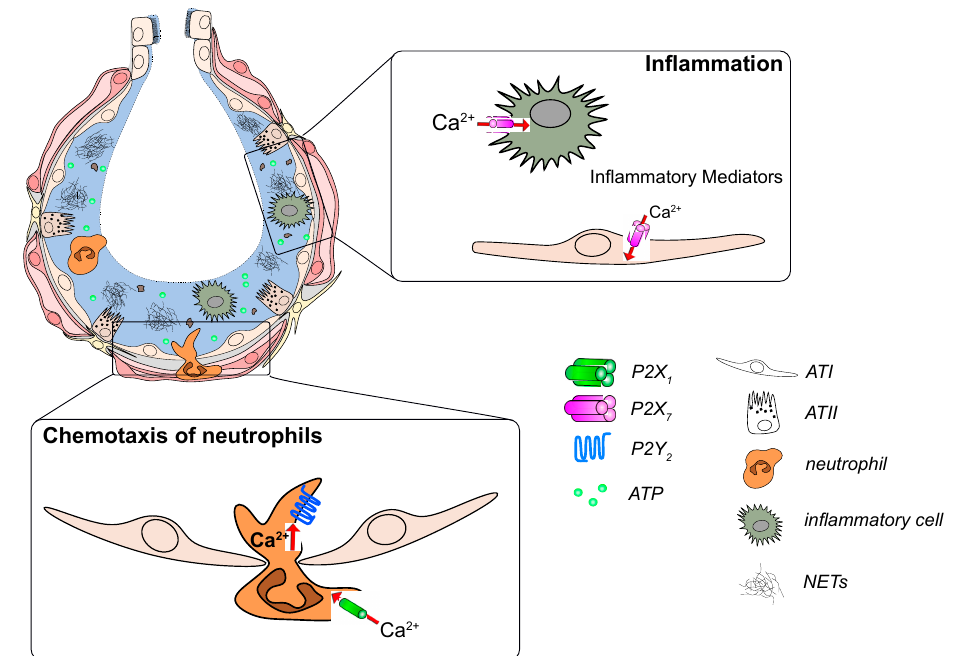
Figure 2. P2 receptor signaling in development and progression of acute respiratory distress syndrome (ARDS) . Increased ATP levels act as a “danger signal” in the damaged alveolus. ATP activates P2X 7 receptors on immune and epithelial cells to promote the release of inflammatory mediators. ATP is also sensed by P2Y 2 and P2X 1 receptors on neutrophils which leads to their infiltration into the alveolus and subsequent activation.